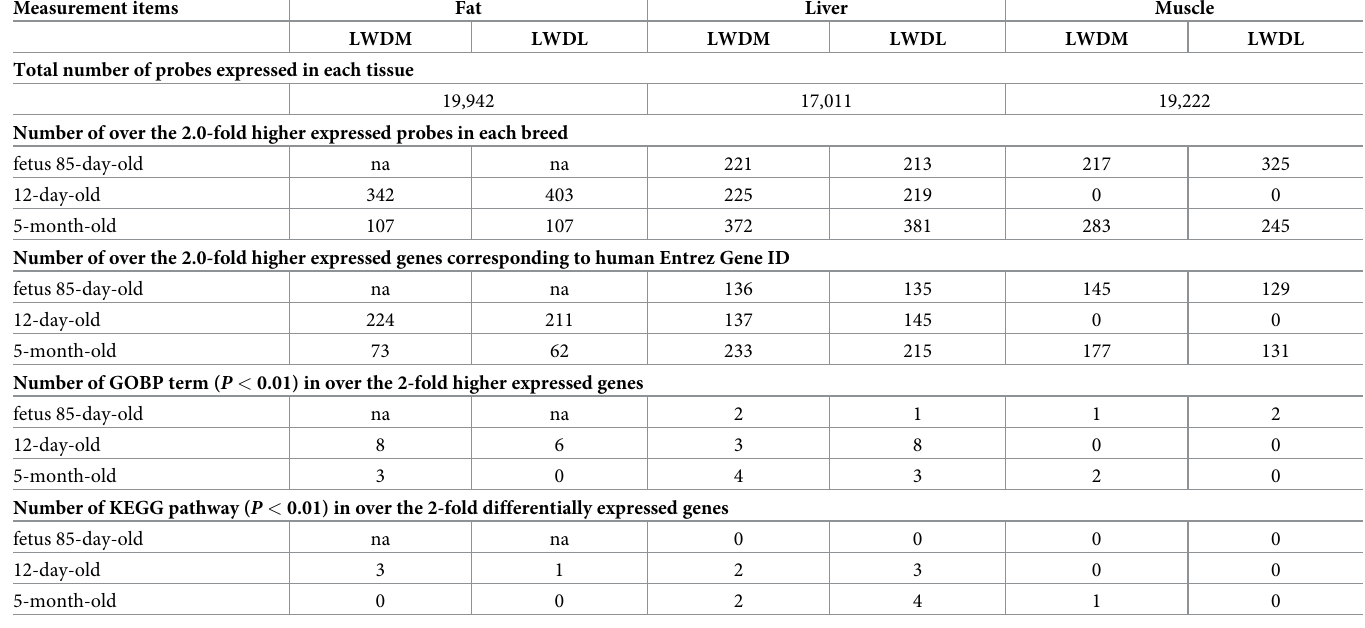
Table 2. Summary of differentially expressed gene profiles in the subcutaneous adipose (fat), liver, and longissimus dorsi muscle (muscle) tissues between LWDL and LWDM pigs. Measurement